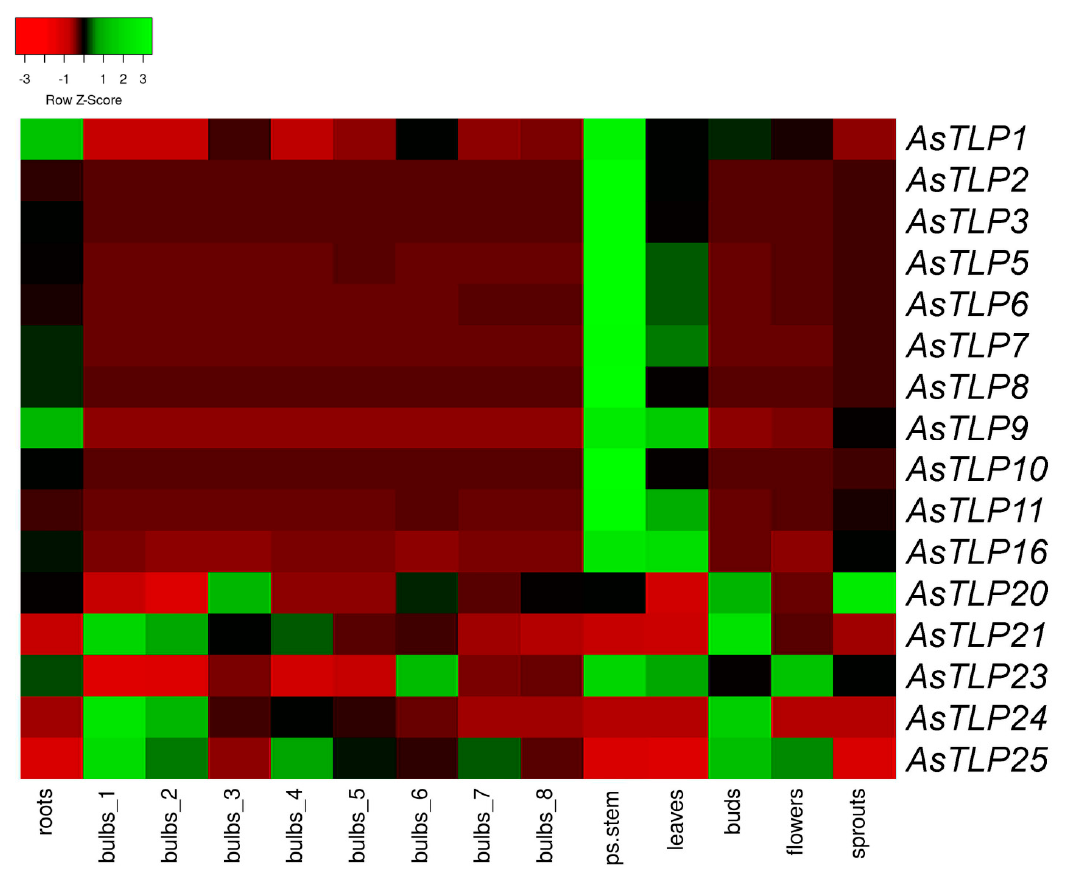
Figure 4. Heatmap of AsTLP gene expression in A. sativum tissues. Gene transcription was analyzed in the roots, bulbs (1, 2, 3, 4, 5, 6, 7, and 8 correspond to 192-, 197-, 202-, 207-, 212-, 217-, 222-, and 227-day-old bulbs), stems (ps.stem), leaves, buds, flowers, and sprouts. The color gradient indicates expression changes from low (red) to high (green).